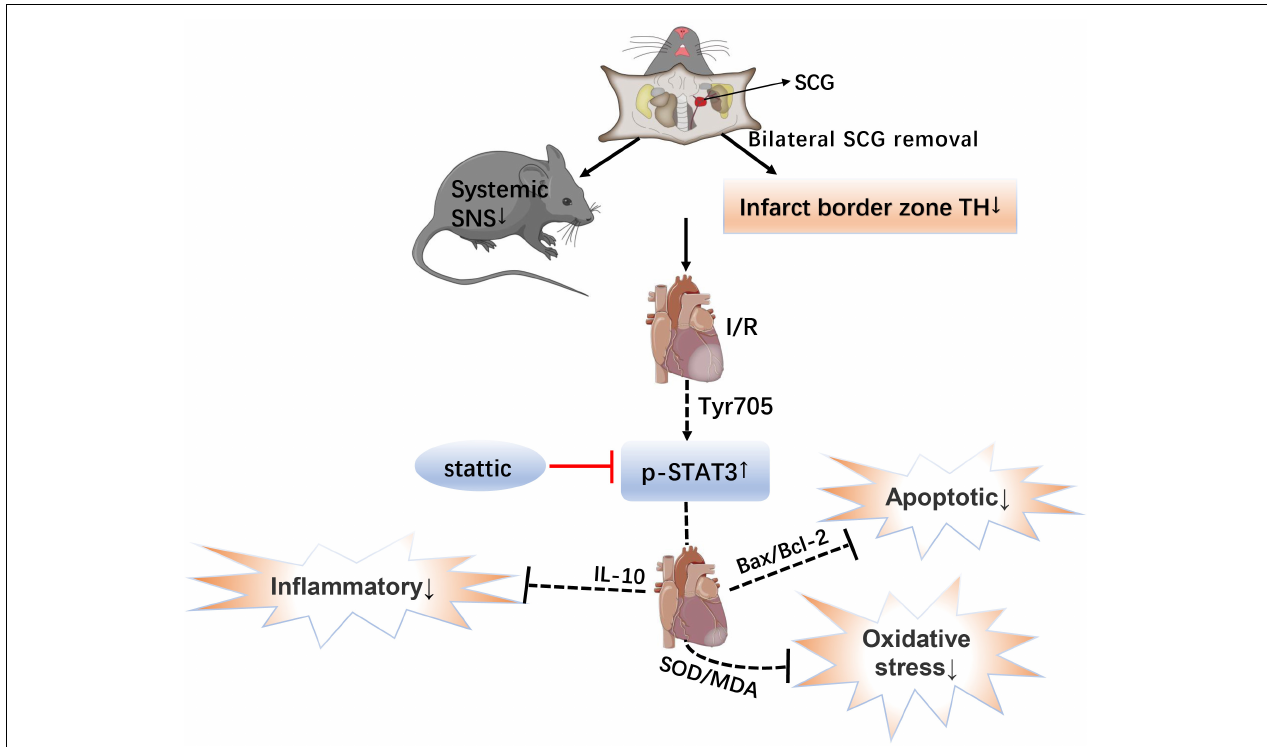
FIGURE 7 | Schematic showing the mechanistic role of the STAT3 signal in myocardial ischemia-reperfusion injury after bilateral superior cervical sympathectomy. SCG, superior cervical ganglion; SNS, sympathetic nervous system; I/R, ischemia-reperfusion; TH, tyrosine hydroxylase; p-STAT3, The transcription factor, signal transducer and activator of transcription 3; IL-10, Interleukin 10; SOD/MDA, superoxide dismutase/malondialdehyde; and Bax/Bcl-2, Bcl-2 Associated X protein/B-cell lymphoma